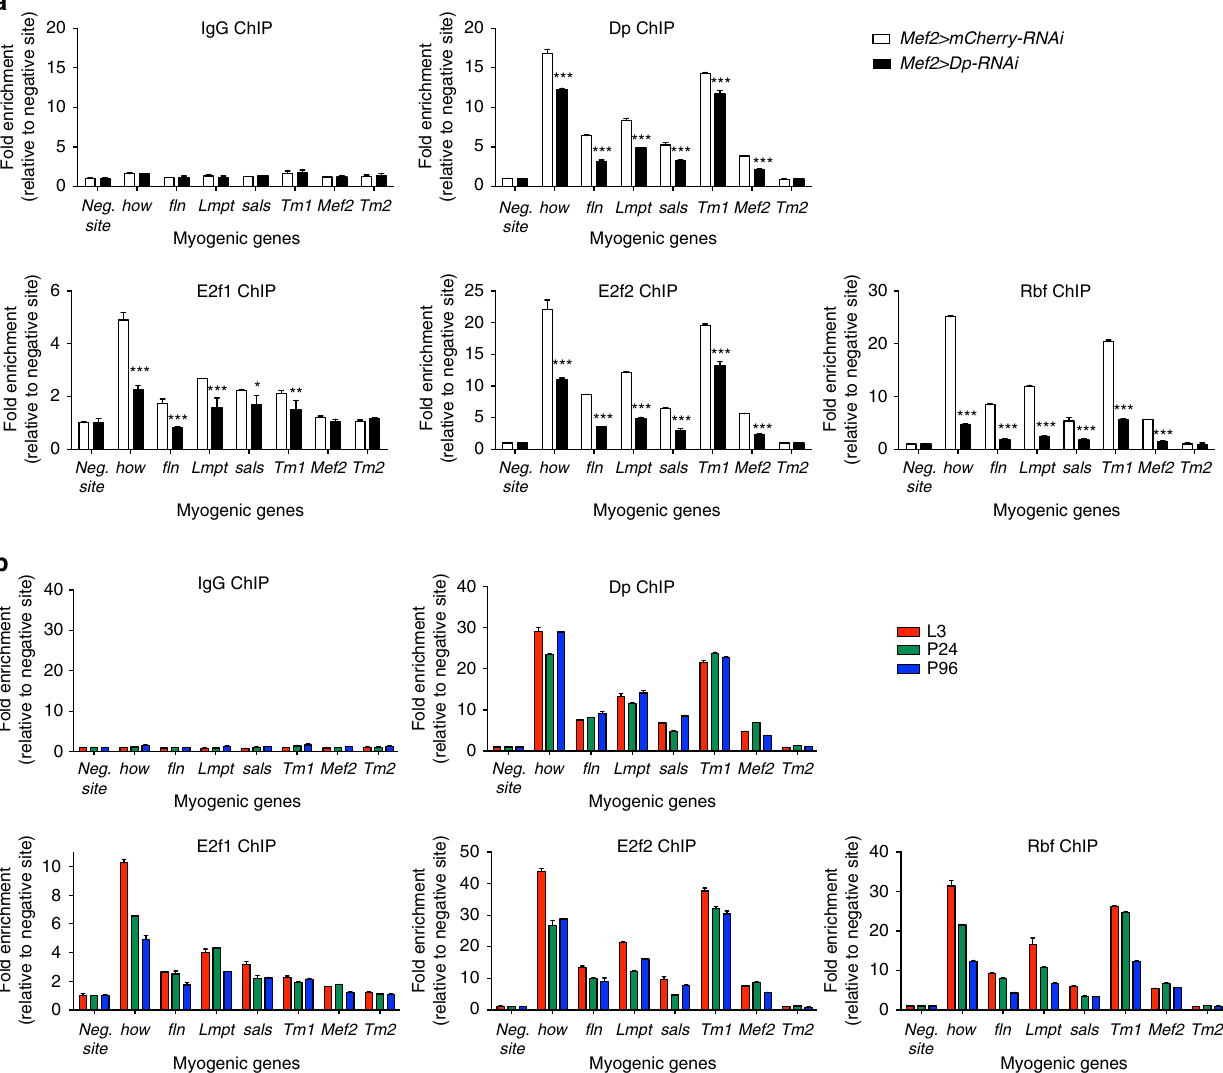
Figure 7 | The E2F/Rb pathway directly controls myogenic gene expression throughout development. E2f1, E2f2, Dp and Rbf proteins are enriched upstream several myogenic genes in a Dp-dependent manner ( a ), and throughout development ( b ). Chromatin from pharate pupae (P96, a , b ), third instar larvae (L3, b ) and early pupae (P24, b ) were immunoprecipitated with antibodies against Dp (top right panel), E2f1 (bottom left panel), E2f2 (bottom middle panel) or Rbf (bottom right panel), and compared with nonspecific control antibodies (top left panel). Muscle genes are how , fln , Lmpt , sals , Tm1 , Mef2 and Tm2 . The negative site does not contain predicted E2F-binding sites. The qPCR data are shown as fold enrichment relative to the negative site for each ChIP sample. Mean ± s.d., n ¼ 2 replicates, two-way ANOVA, * P o 0.05, ** P o 0.01, *** P o 0.001. Genotypes are ( a ) Mef2-GAL4/UAS-mCherry-RNAi (white bar) and UAS-Dp-RNAi;Mef2-GAL4 (black bar), and ( b ) Mef2-GAL4/UAS-mCherry-RNAi .